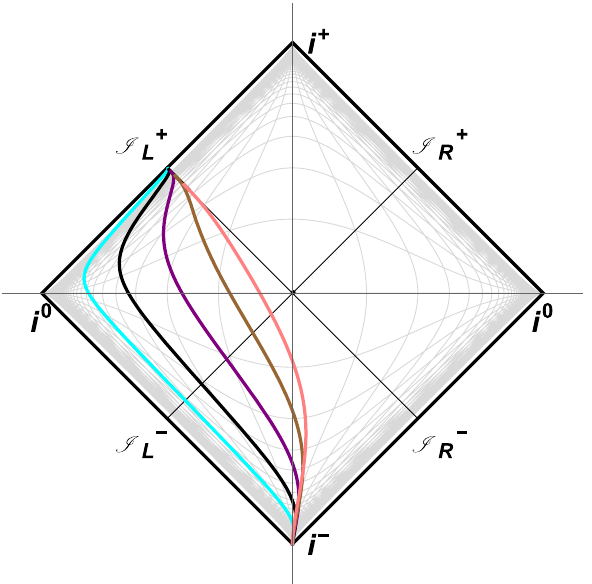
Fig. 2 The trajectory Eq. (11) in a Penrose conformal diagram. The horizon has been set to v H = 0. For illustrative emphasis on the asymp- totic behavior, the ratio Q / M = 86% is fixed, but the mass is changing, M = 2 , 1 , 2 − 1 , 4 − 1 , 8 − 1 ; for cyan, black, purple, brown, pink, respec- tively. The mass dramatically affects the conformal trajectory, demon- strating the horizon approach is more rapid at late times for higher value of the mass